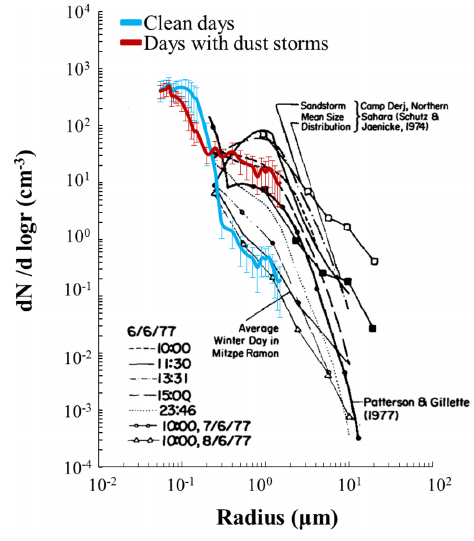
Figure 8. Average size distributions and standard deviation as mea- sured during dust storm and clean days (in brown and blue, respec- tively) plotted on top of the results of dust particle measurements in Israel and in other locations as presented by Levin et al.